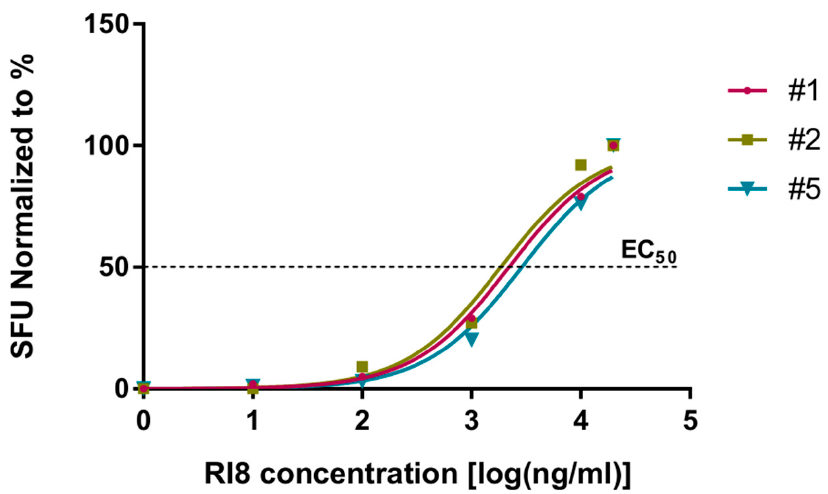
Figure 4. Analysis of peptide-sensitizing capacity of peptide Rev-RI8. A total of 1 × 10 5 cells each from Rev-RI8-specific T-cell lines from the three HLA-B*52-positive subjects, #1, #2 and #5, were incubated with serial dilutions of peptide Rev-RI8 in γ -IFN ELISpot assays. Shown are adjusted spot-forming units (SFUs) after subtraction of the background. In this graph, 100 % represents the highest frequencies of SFUs determined for the individual T-cell line. The 50% peptide sensitizing activity (EC 50 ) was calculated using non-linear curve regression analysis. EC 50 values: subject #1: 2.2 µg/mL,